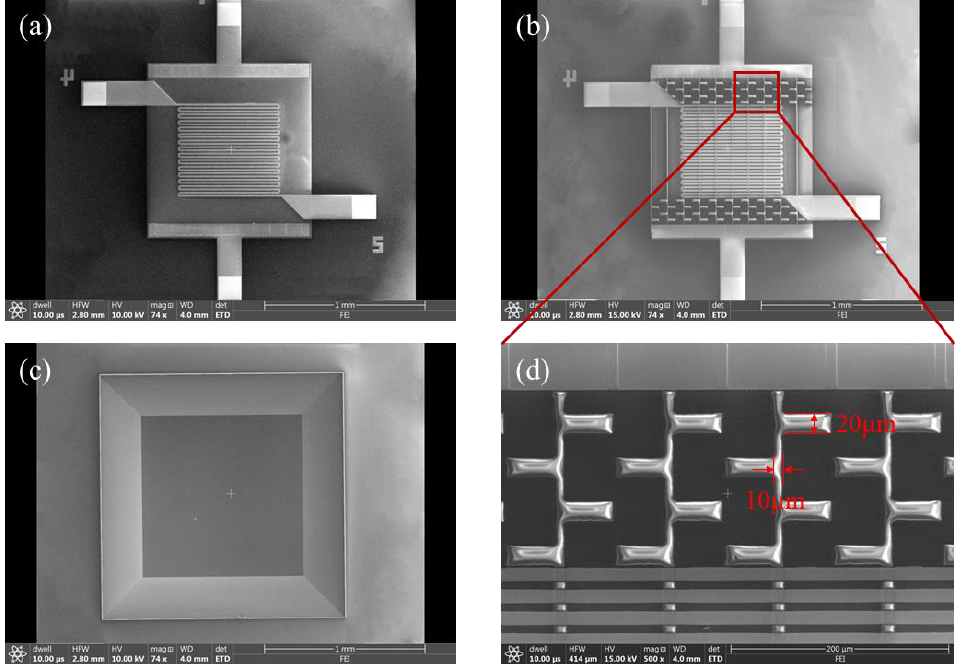
Figure 2. SEM of microhotplates: ( a ) top view of Sample − 1, ( b ) top view of Sample − 2, ( c ) cavity formed by wetting etching at the back side and ( d ) detailed view of compensation structure of Sample −